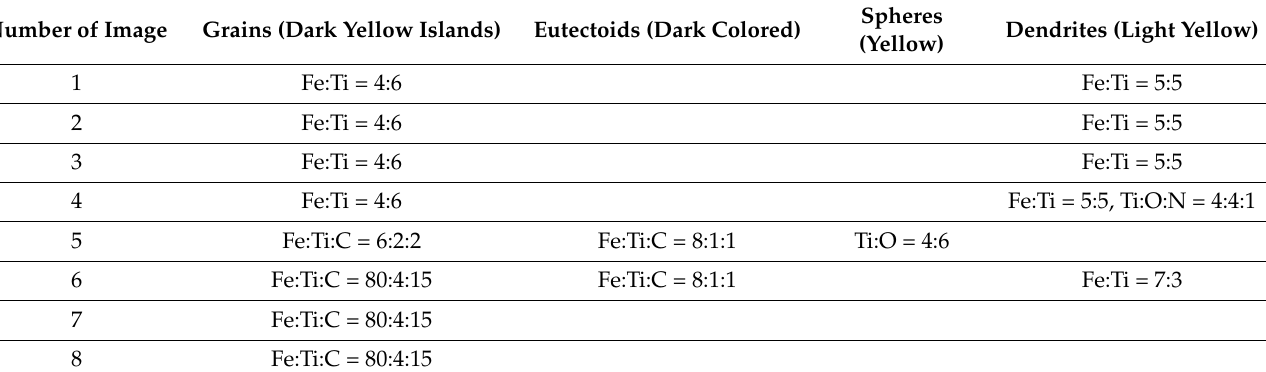
Figure 4. Optical micrographs showing the typical microstructures of the DED of a Ti-Fe multilayer sample: central image has a magnitude of 25; detailed pictureds have magnitudes of 800. Table 2. Structural components of graded structures from Figure 4 (2nd